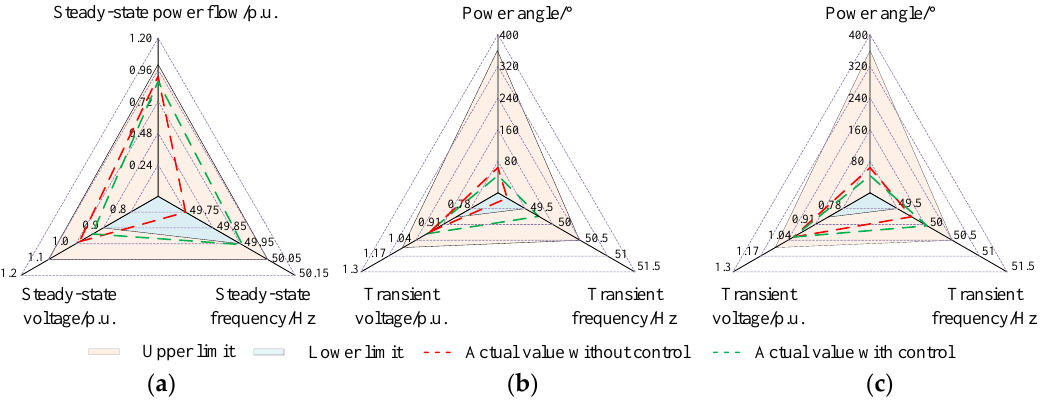
Figure 8. ( a ) Static indices; ( b ) Dynamic indices corresponding to the minimum transient frequency and voltage; ( c ) Dynamic indices corresponding to the maximum transient frequency and voltage.